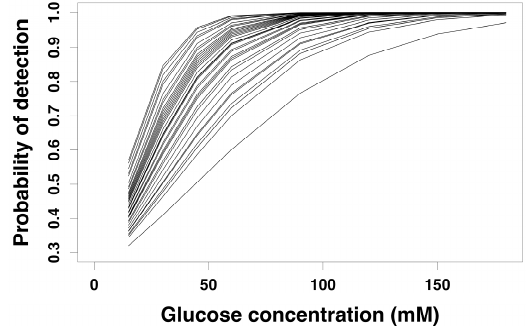
Figure 1. Sweet taste threshold detection curves of all participants. Each line of this figure represents the best-fit curve of each participant generated by a binomial regression model with a common intercept and separate slopes. The figure was generated from the average threshold data of the four repeated sessions. n = 44.